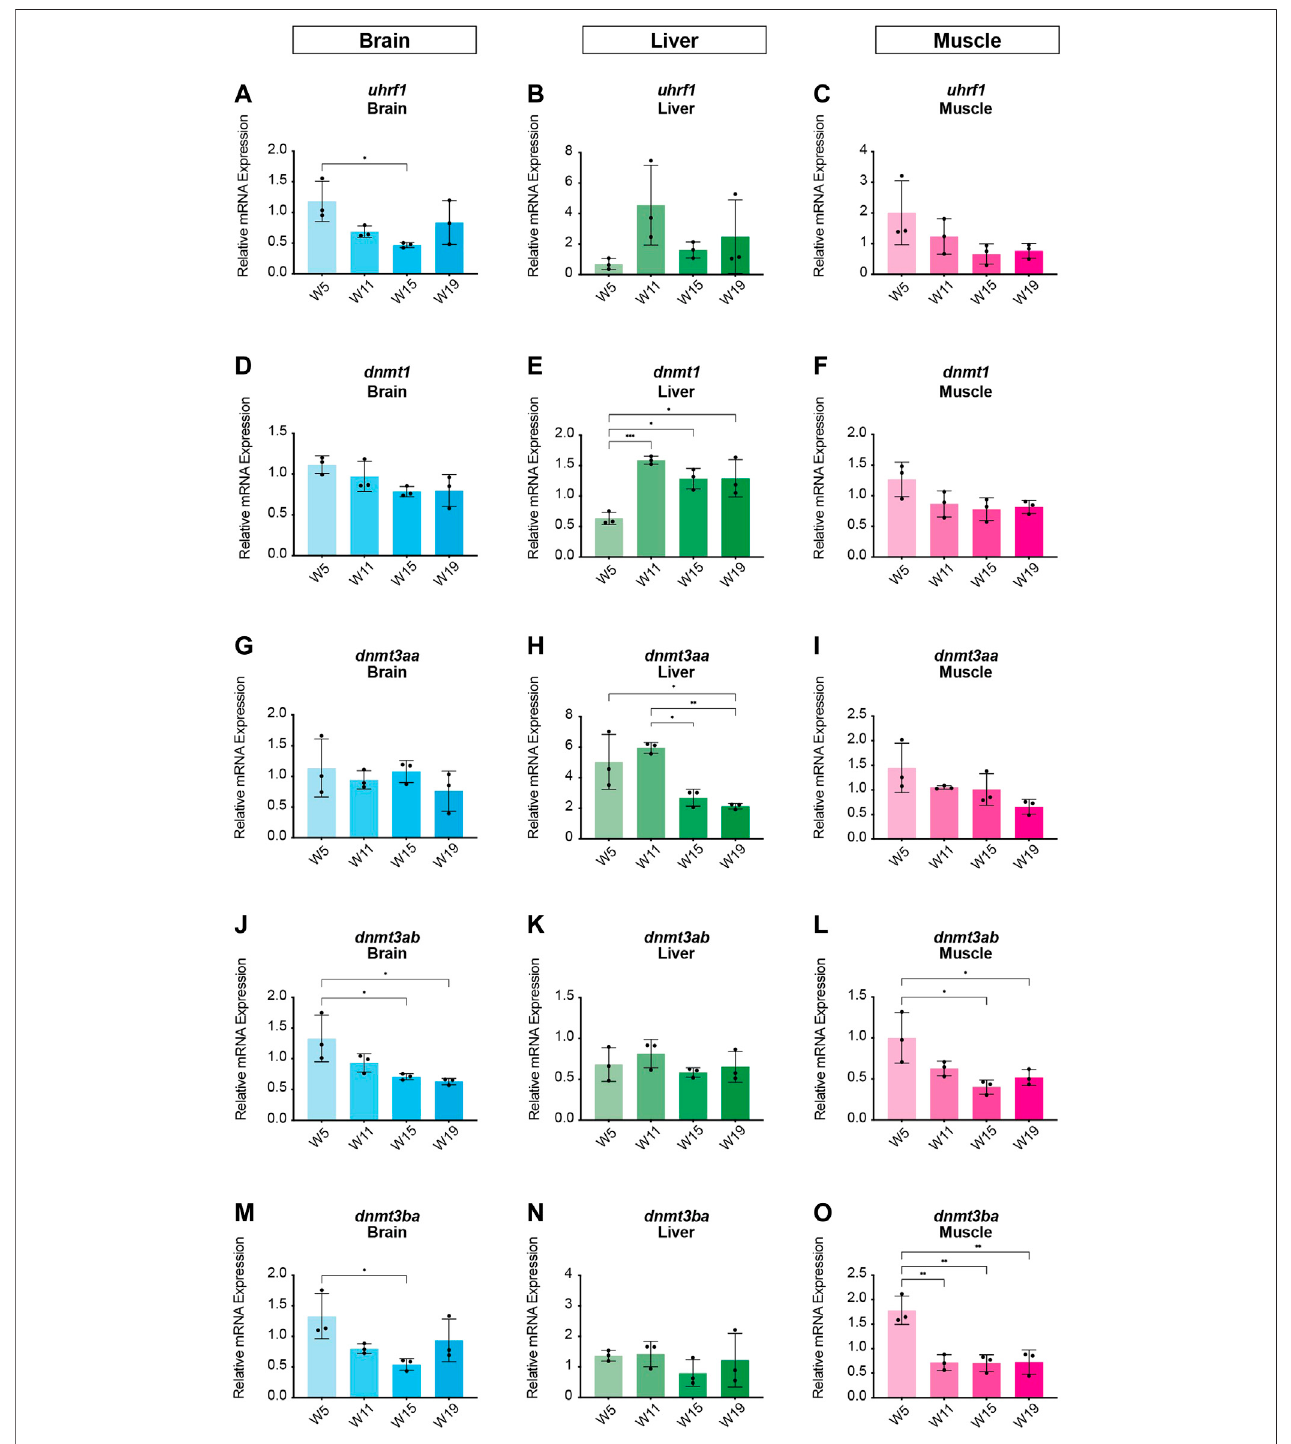
FIGURE 5 | Age-dependent expression analysis of killi fi sh DNA methyltransferases and recruitment factors. Quantitative Real-time PCR of killi fi sh DNMT1 recruitment factor uhrf1 (A – C) , dnmt1 (D – F) , dnmt3aa (G – I) , dnmt3ab (J – L) , dnmt3ba (M – O) in brain, liver, and muscle at 5 (W5), 11 (W11), 15 (W15), and 19 (W19) weeks of age. Individual dnmt/uhrf1 expression was normalized to tbp housekeeping gene expression. All error bars represent SD of three biological replicates. Statisticalsigni fi canceswerecalculatedwithone-wayANOVAusingTukey ’ smultiplecomparisonscomparingthemeansofalltimepointswitheachother.Relative mRNA expression is shown. ns: p > 0.05; *: p ≤ 0.05; ** p ≤ 0.01; ***: p ≤ 0.001; ****: p ≤ 0.0001.